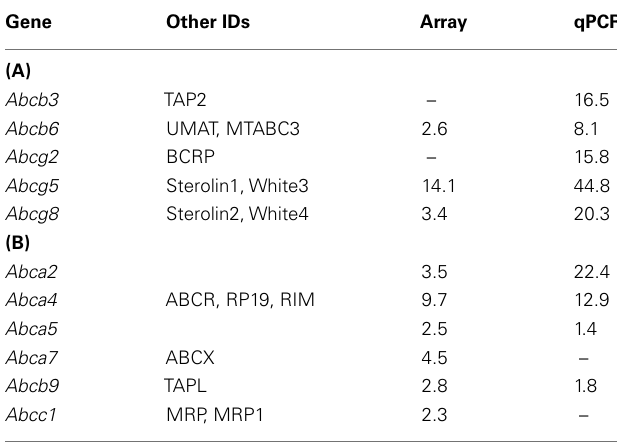
Table 5 | Efflux (ABC) transporter expression in embryonic (A) and adult (B) mouse choroid